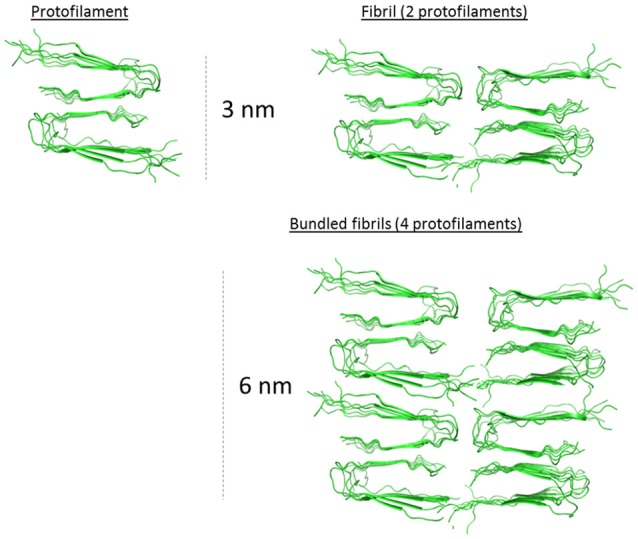
2.5–3.0 nm protofilament of Aβ1-40 derived from the solid state NMR structure model from Petkova et al. (2006). Hypothetical assembled protofilaments for discussions regarding the macro-arrangement of the filaments in the 5.0–5.5 nm bundled fibril as determined by AFM (Figure 5). PDB coordinates from 2 LMO.